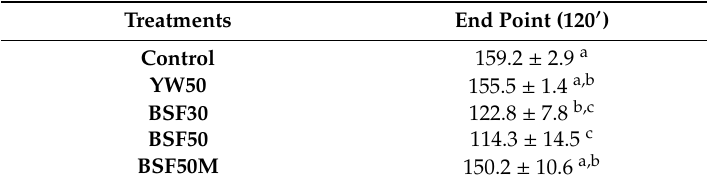
Table 4. Protein hydrolysis (mg / mL of free amino acids) of intestines of the fish fed di ff erent treatments ( n =